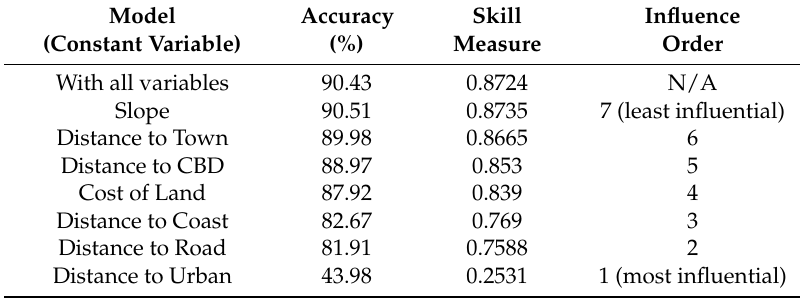
Table 5. Relative significance of driver variables generated by forcing independent variables to be constant.